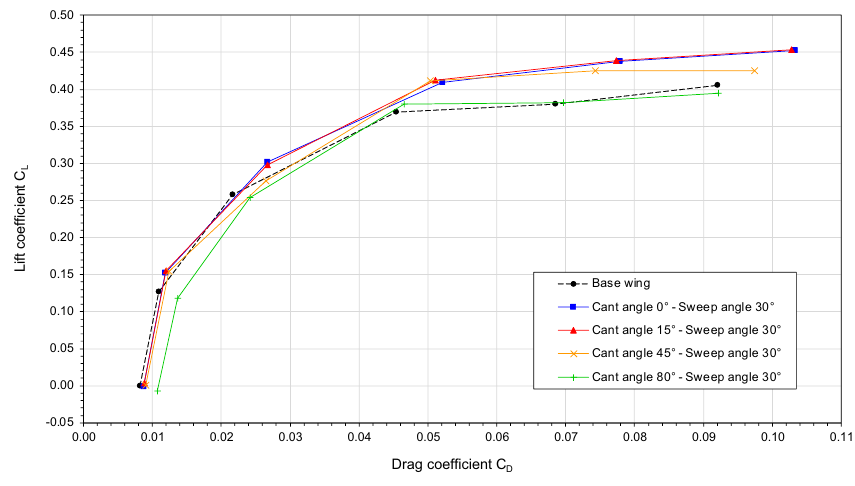
Figure 11. Drag polar at Mach number 0.8395, winglet sweep angle 30 ◦ and different values of cant angle.